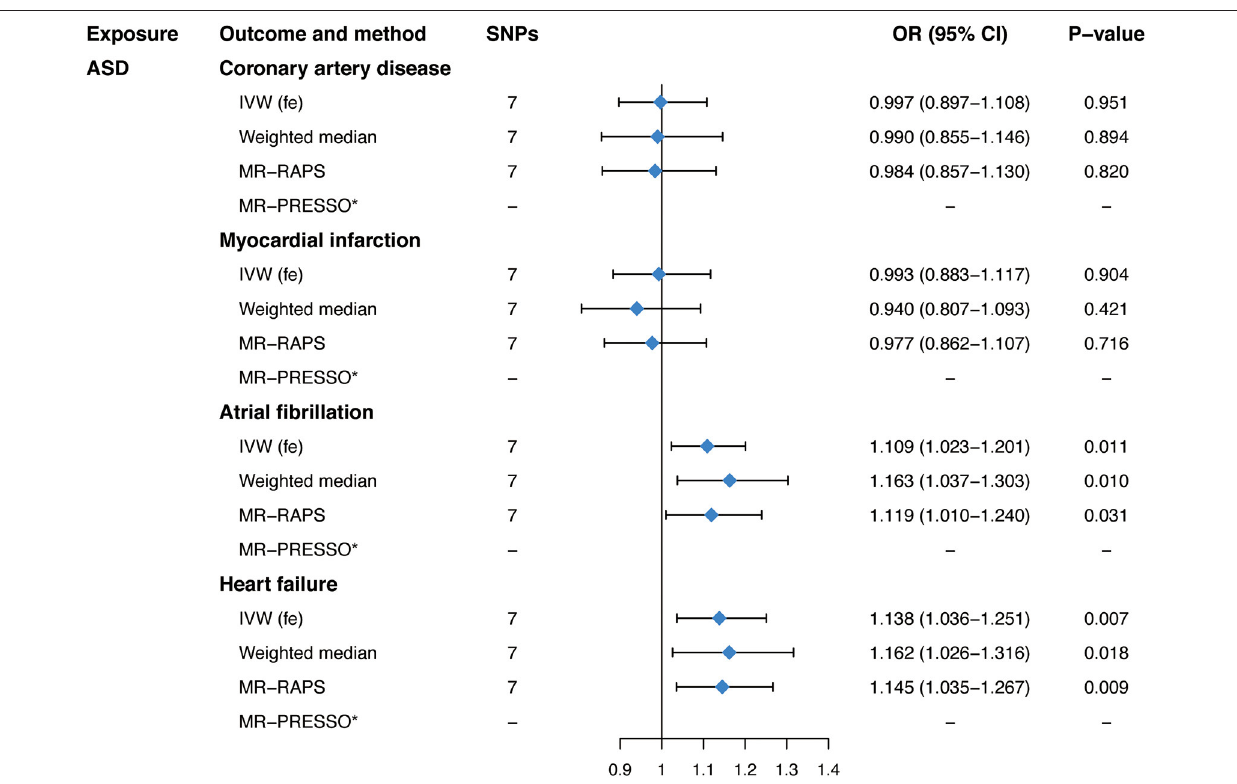
FIGURE 1 | Mendelian randomization estimates of genetically predicted autism spectrum disorder on four cardiovascular diseases. SNPs, single-nucleotide polymorphisms; OR, odds ratio; CI, confidence interval; ASD, autism spectrum disorder; IVW (fe), fixed-effects inverse-variance weighted; MR-RAPS,